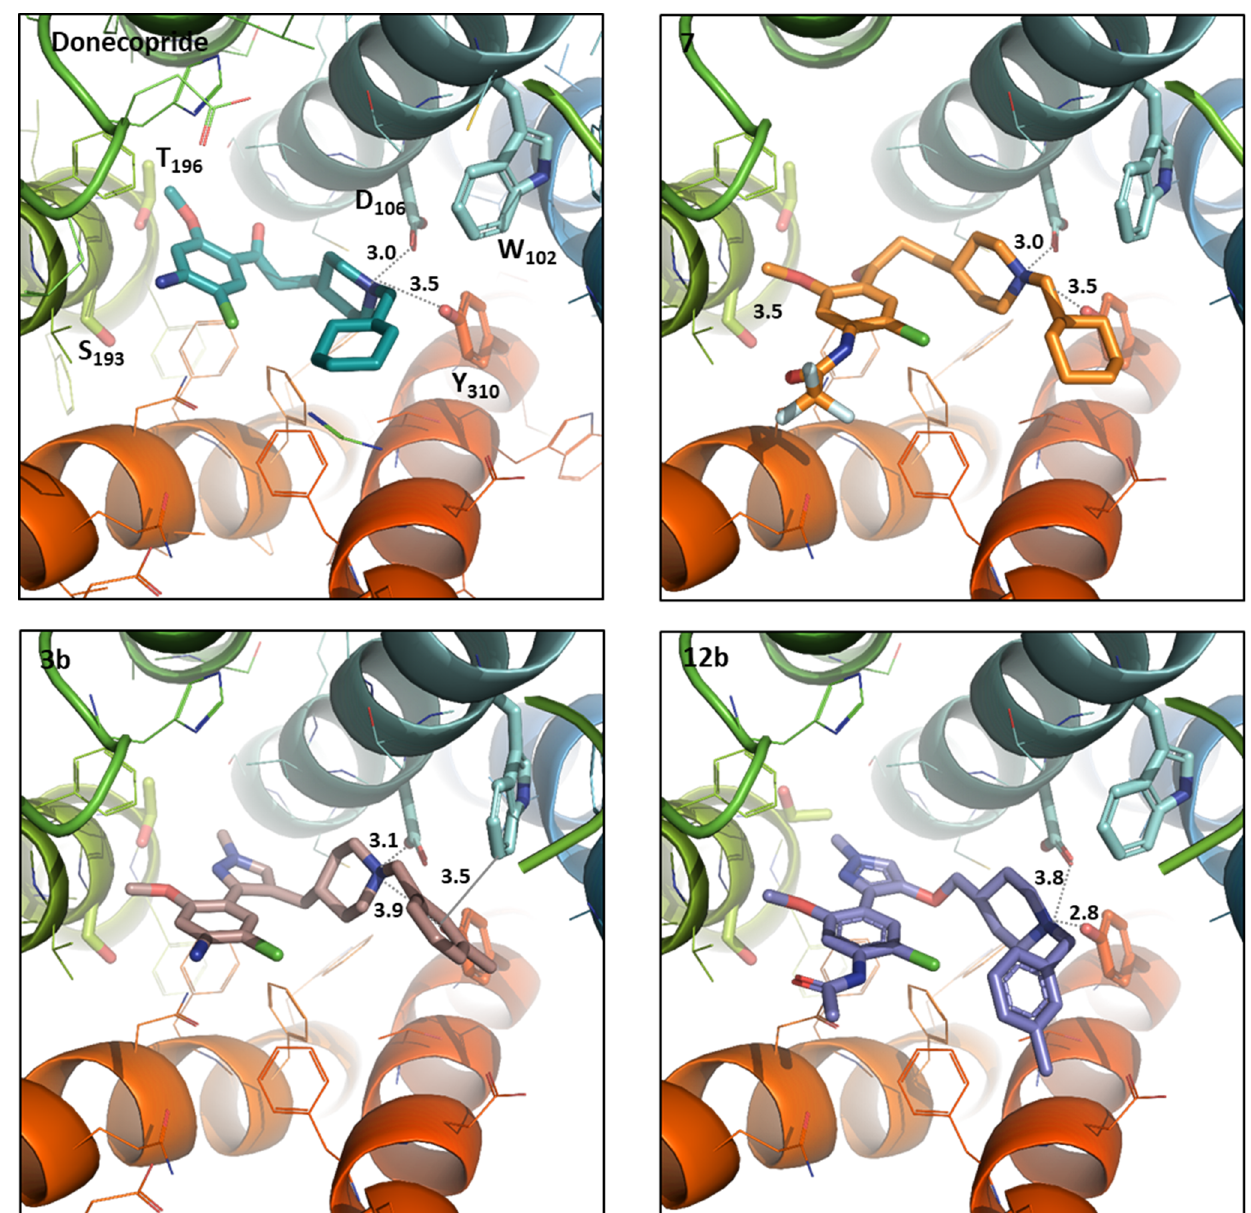
Figure 4. Donecopride (green) position compared to the compound 7 (orange), 3b (pink) and 12b (purple) positioned in h- 5HT 6 R binding sites using the docking studies. The compound and the selected side chains of the binding site residues are in stick and the protein in ribbon representation. This figure was made with PYMOL (DeLano Scientific, 2002, San Carlo, CA, USA) and the protein is presented in the same orientation in all four images.